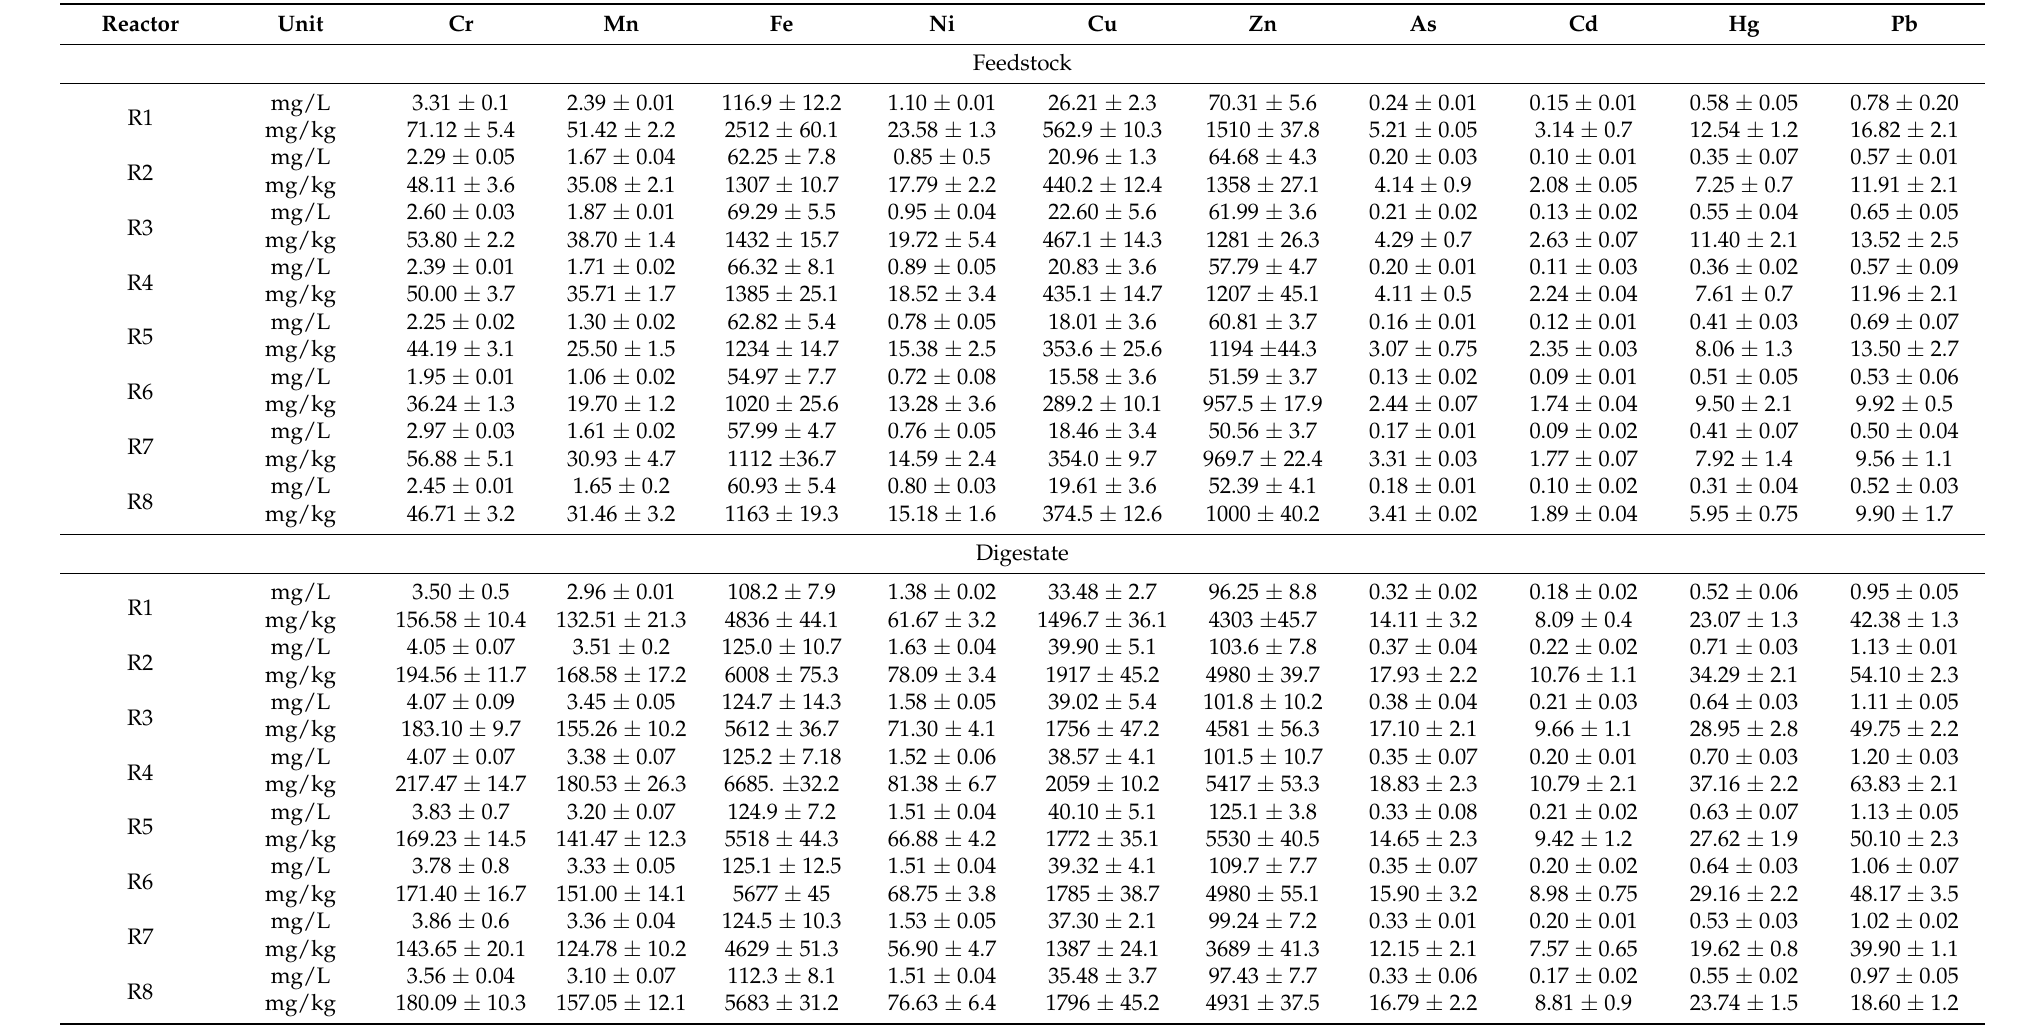
Table 4. Contents of micro-elements in the experimental series (average values and standard deviations are